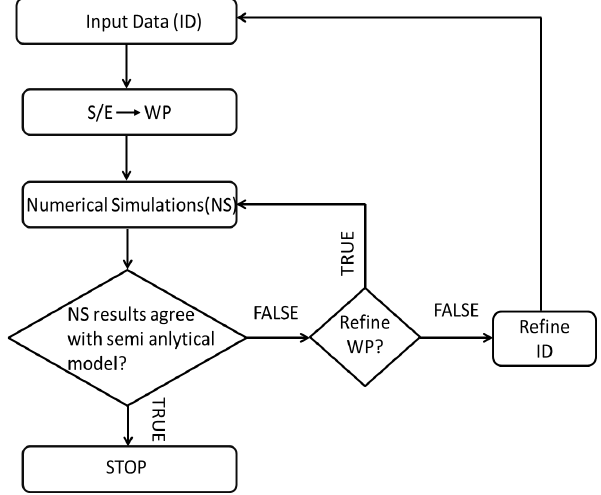
Figure 1. FEL design strategy flow chart: (1) Input data (beam and undulator parameters and the desired wavelength emission) (2) S / E −→ WP = use of Scaling/Empirical formula to find the working point (3) Numerical Simulations (NS) = use of numerical codes to refine the details of the preliminary definition of the space parameters (4) Loop the process, changing the input data and/or the working point, until the benchmark with semi-analytical model is true.